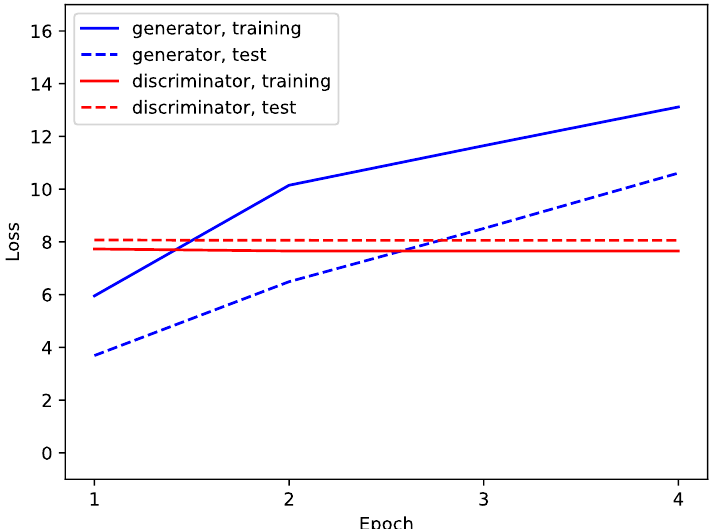
Figure 7. Training and test loss of the generator and discriminator for the first four